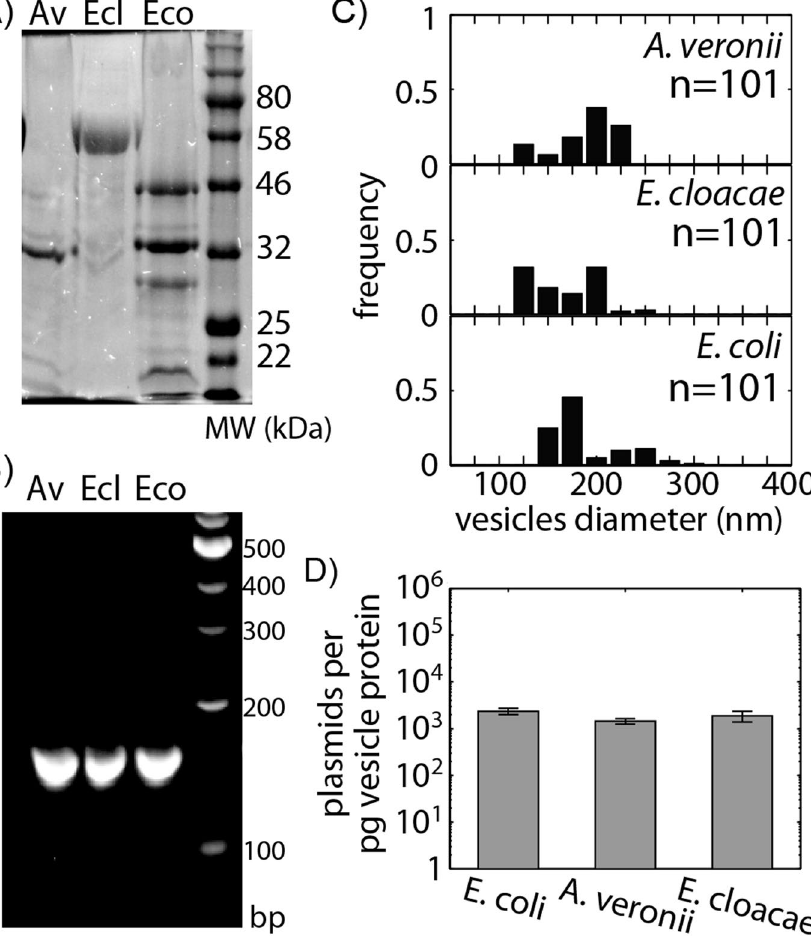
Figure 3. Variation of EVs and plasmid packaging is less dependent on donor species. ( A ) The production of EVs from A . veronii (Av), E . cloacae (Ecl), and E . coli (Eco), are measured using SDS-PAGE to quantify protein concentration. EV production is similar across species. ( B ) Packaging of pLC291 is confirmed using PCR amplification from purified vesicles. ( C ) Size distributions of EVs measured by dynamic light scattering shows similar diameters of vesicles harvested from all three species. ( D ) Vesicle DNA content quantified by qPCR was used to calculate plasmid copy number per pg of vesicle protein. P-values ≤ 0.0002. Error bars signify standard